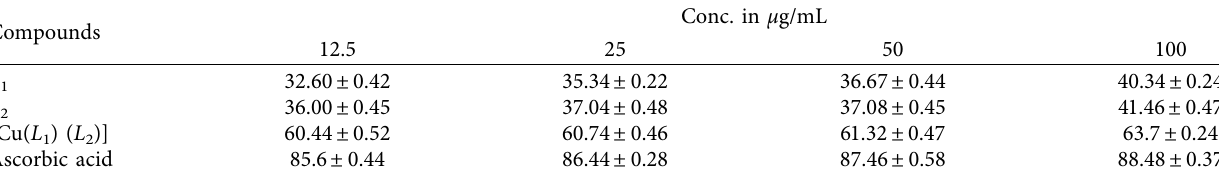
Table 3: percentage of antiradical activities of the compounds.